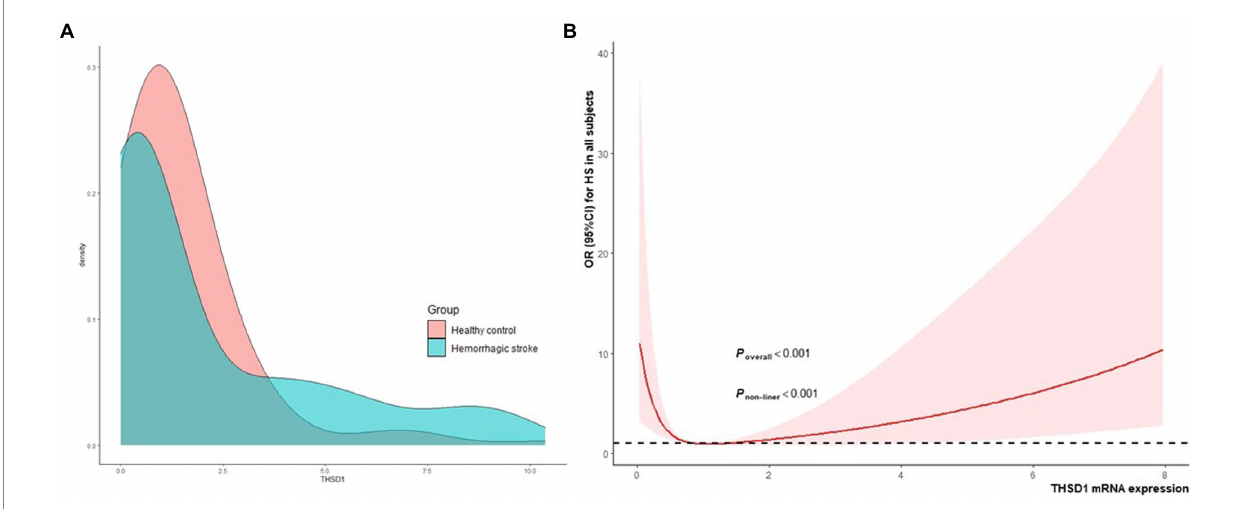
FIGURE 2 The kernel density estimation distribution of THSD1 mRNA and the association between THSD1 mRNA expression (A) , and the risk of HS in the total population was evaluated by the restricted cubic spline regression (B) . Estimates adjusted for age, gender, hypertension, diabetes, and dyslipidemia. The p -value for overall association and the p -value for non-linearity were annotated in the figure.